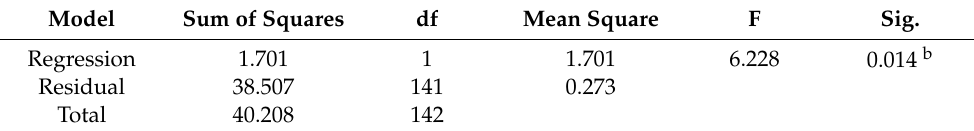
Table 9. ANOVA for multiple correlations between TK, TCK, TPK, and TPACK. Model Sum of Squares df Mean Square F Sig. Regression 1.701 1 1.701 6.228 0.014 b Residual 38.507 141 0.273 Total 40.208